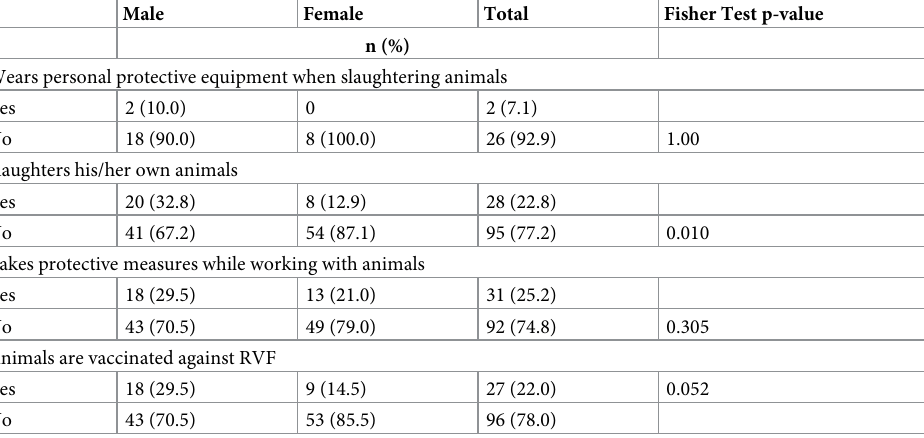
No 0.305 Animals are vaccinated against